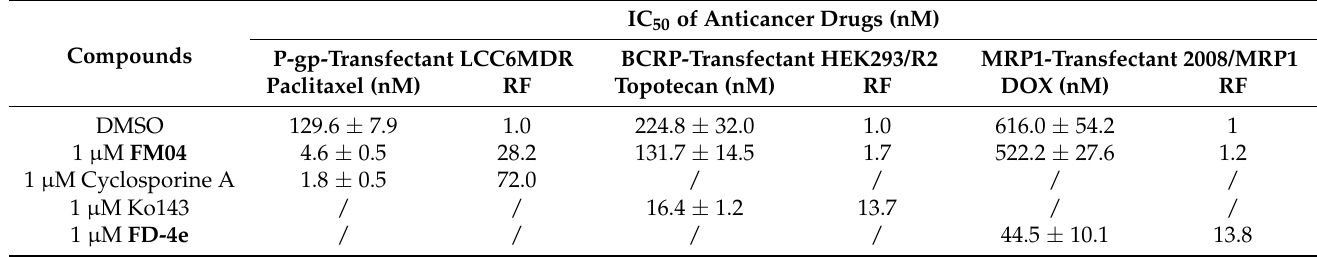
Table 2. Selectivity of FM04 towards P-gp, BCRP and MRP1